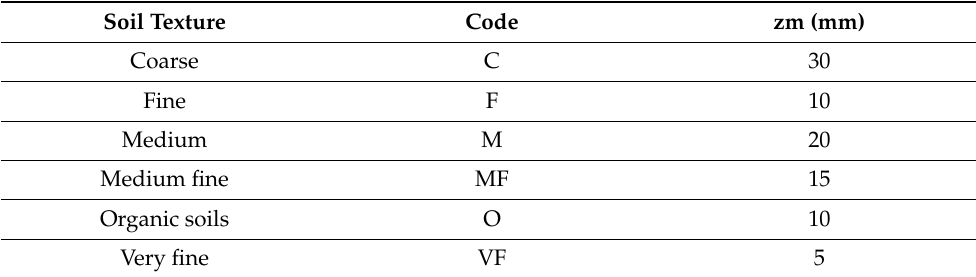
Table A5. PESERA zm estimation according to soil texture class [13].